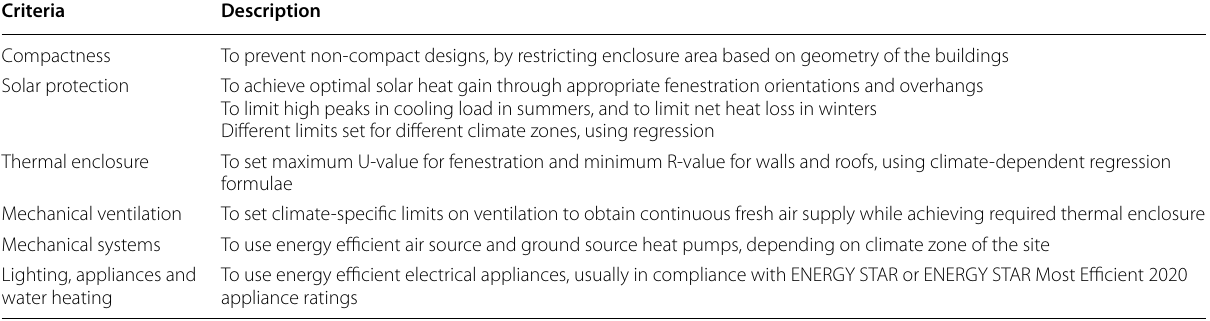
Table 2 Prescriptive path to PHIUS certified passive buildings